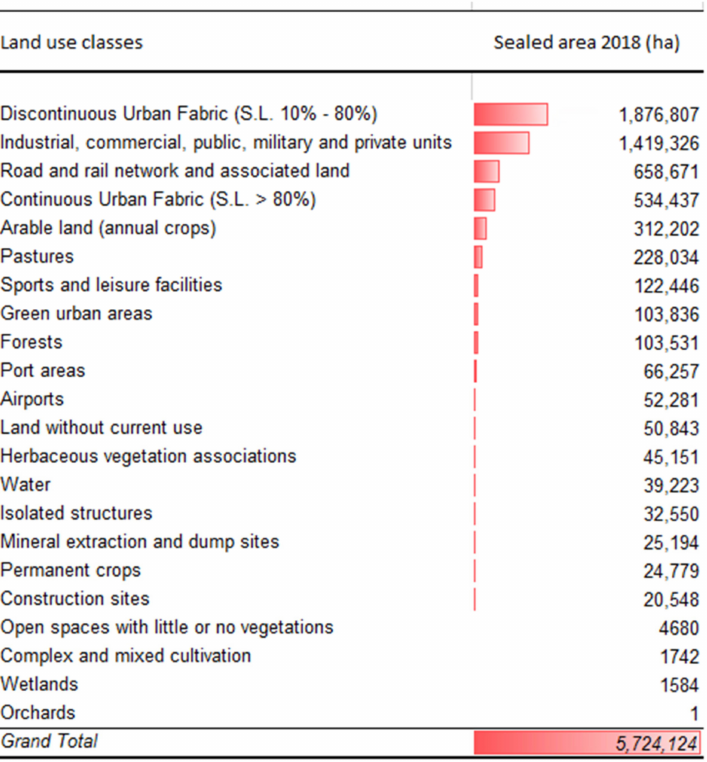
Figure A1. Sealed area per Urban Atlas classes (2018). Derived from the Imperviousness Degree dataset of the Copernicus Land Monitoring Service [50]. The cut-off value of 30% was applied to calculated sealed vs. non-sealed